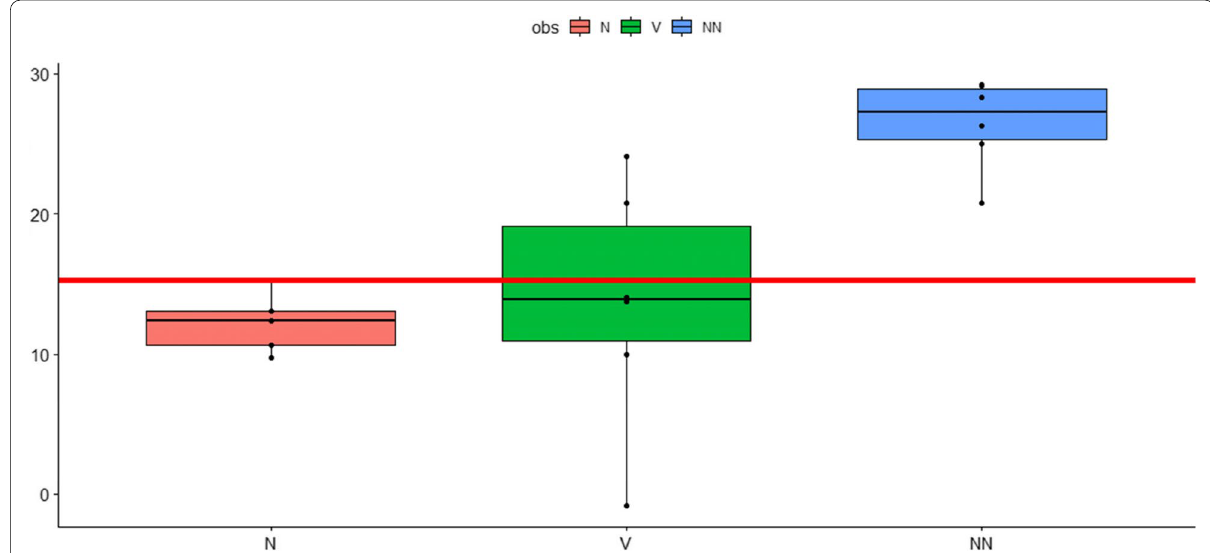
Fig. 4 Non-mitochondrial Oxygen Consumption Rates (OCR). Non-mitochondrial OCR in pmolO 2 /min were measured before, after the first 10-pass OHT and after the second 10-pass OHT one week later. Cumulative data from six patients expressed as mean versus v); 0,716 (n versus v); 0,0,000,147 (n versus nn). COHEN: 1,939,925 (NN versus V); 0,2,120,872 (N versus V); 5,053,979 (N versus NN). ANOVA: 0,0,043,277 (NN versus V); 0,99,117,745 (N versus V); 0,0,027,815 (N versus NN). V: before OHT; N: after the first OHT; NN: after the 2. OHT (one week later). Y-Axis:pmol O2/min; X-axis: sampling